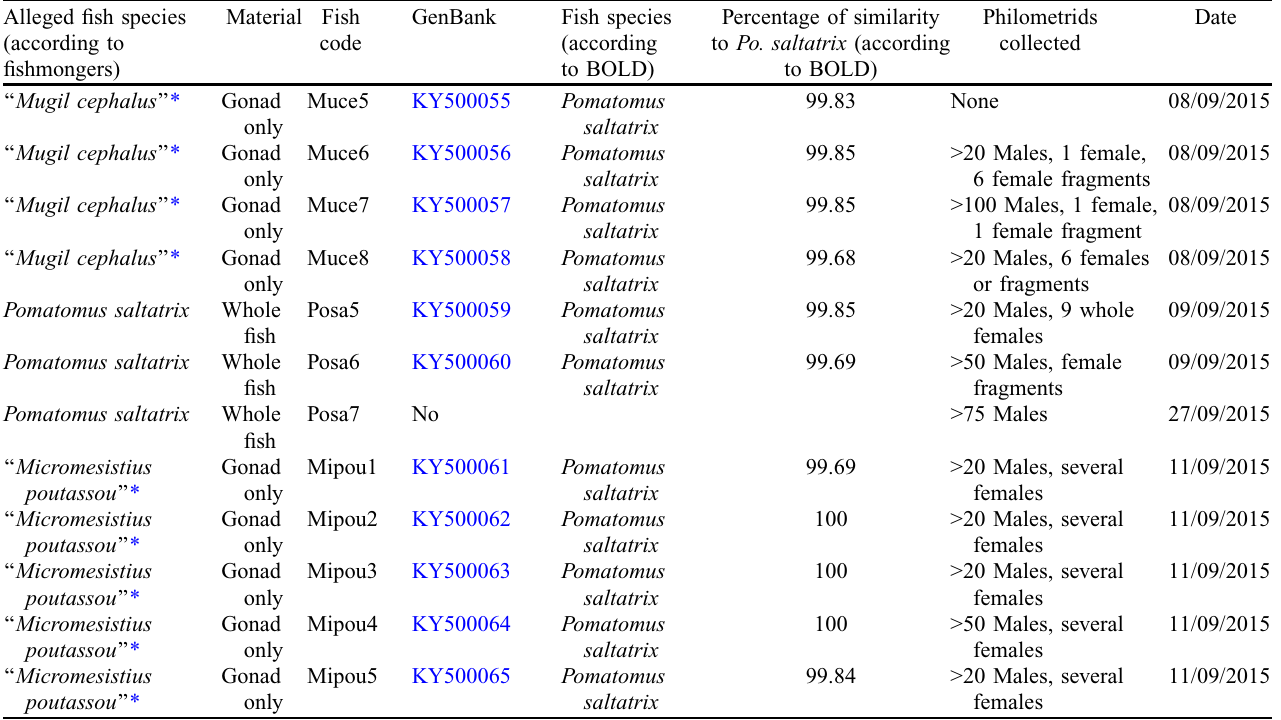
Table 1. Pomatomus saltatrix : fish gonad collected and fish identification. Alleged fish